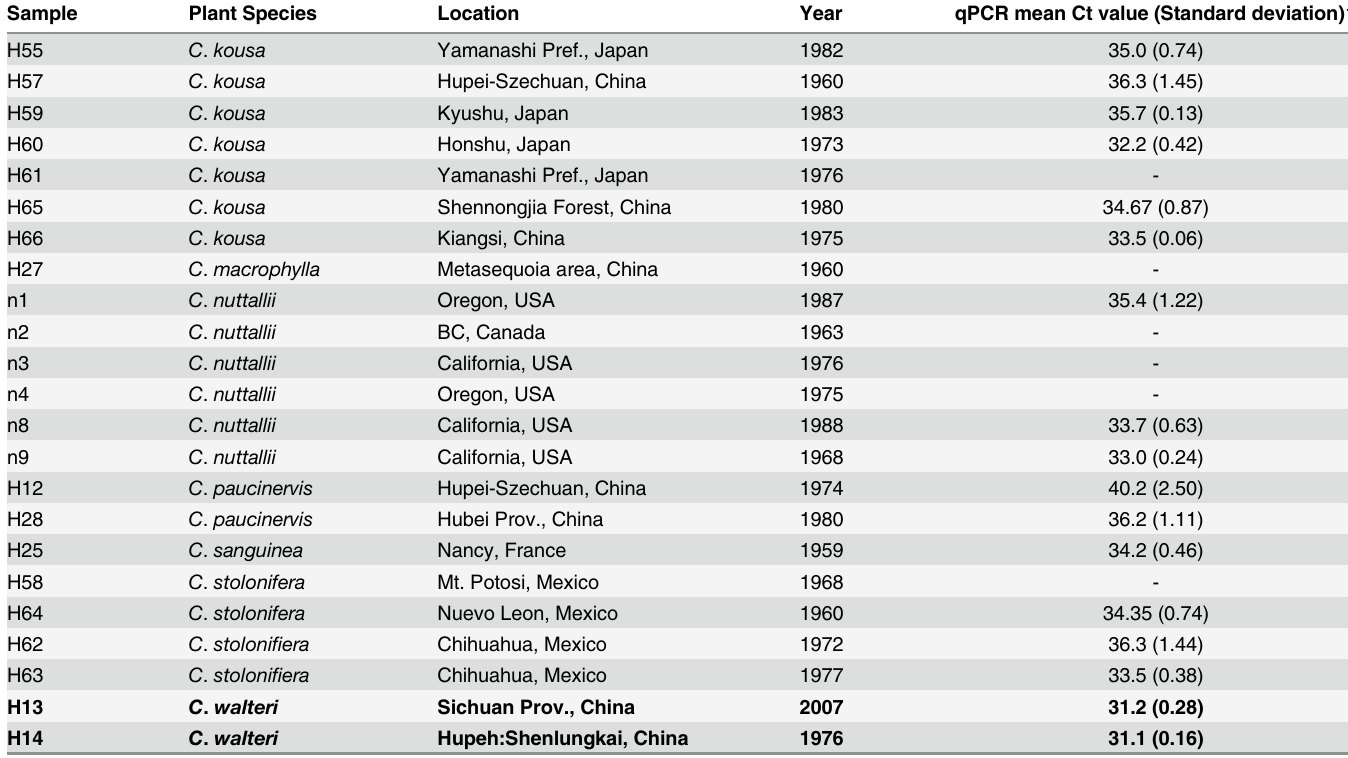
* Highlighted in bold are the samples with positive detection of Discula destructiva , with Ct value < 32.0, and con fi rmed with DNA sequencing. -: no ampli fi cation